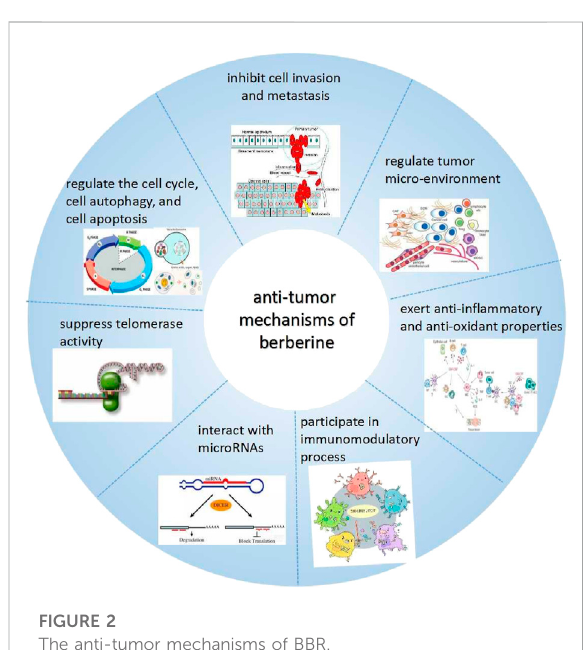
FIGURE 2 The anti-tumor mechanisms of